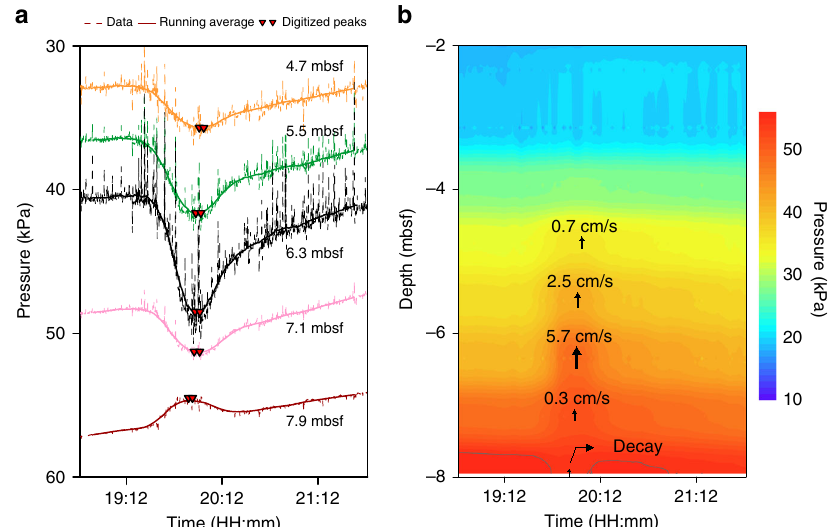
Fig. 4 Gas bubble velocities. a Pore-pressure measurements on the fi ve lowermost sensors in the sediments measured at site PZM1 (record timing in Fig. 2). b Rising velocity of gas bubbles calculated from pore-pressure fl uctuations in ( a ) projected on pore pressure contours at site PZM1.